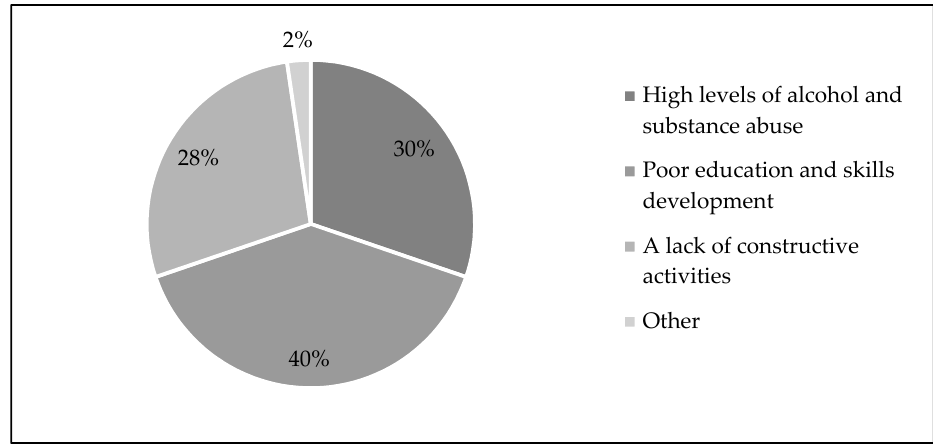
Figure 2. What community members do not appreciate about RLM. Source: Company A, 2017.